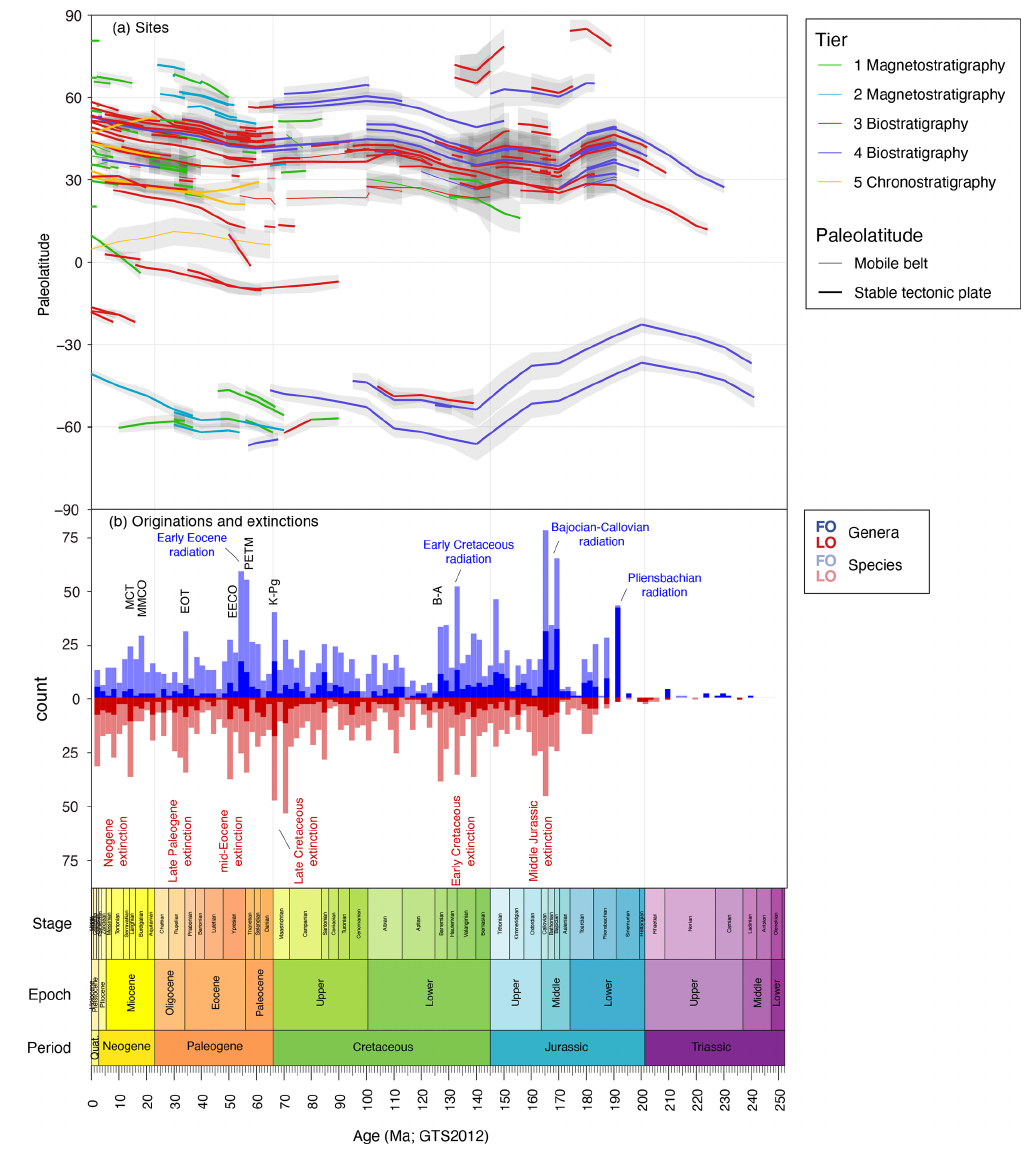
Figure 3. Data in DINOSTRAT. (a) Paleolatitude and age span of sites used in DINOSTRAT. Colors correspond to tier; line thickness sepa- rates sites on stable oceanic or continental plates from those in mobile orogenic belts. Grey envelopes represent the error of the paleolatitude reconstruction inherited from the paleomagnetic reference frame (see Van Hinsbergen et al., 2015). (b) Dinocyst events in DINOSTRAT, filtered for oldest FOs (blue) and youngest LOs (red) of dinocyst species (lighter shade) and genera (darker shade), in 2Myr bins. Several phases of climatic environmental change are highlighted in black: Barremian–Aptian boundary (B–A), Cretaceous–Paleogene boundary (K– Pg), Paleocene–Eocene boundary (PETM), Early Eocene Climatic Optimum (EECO), Eocene–Oligocene transition (EOT), Mid-Miocene Climatic Optimum (MMCO) and Miocene climatic transition (MCT). Extinction and radiation phases in dinocysts are highlighted in red and blue text,